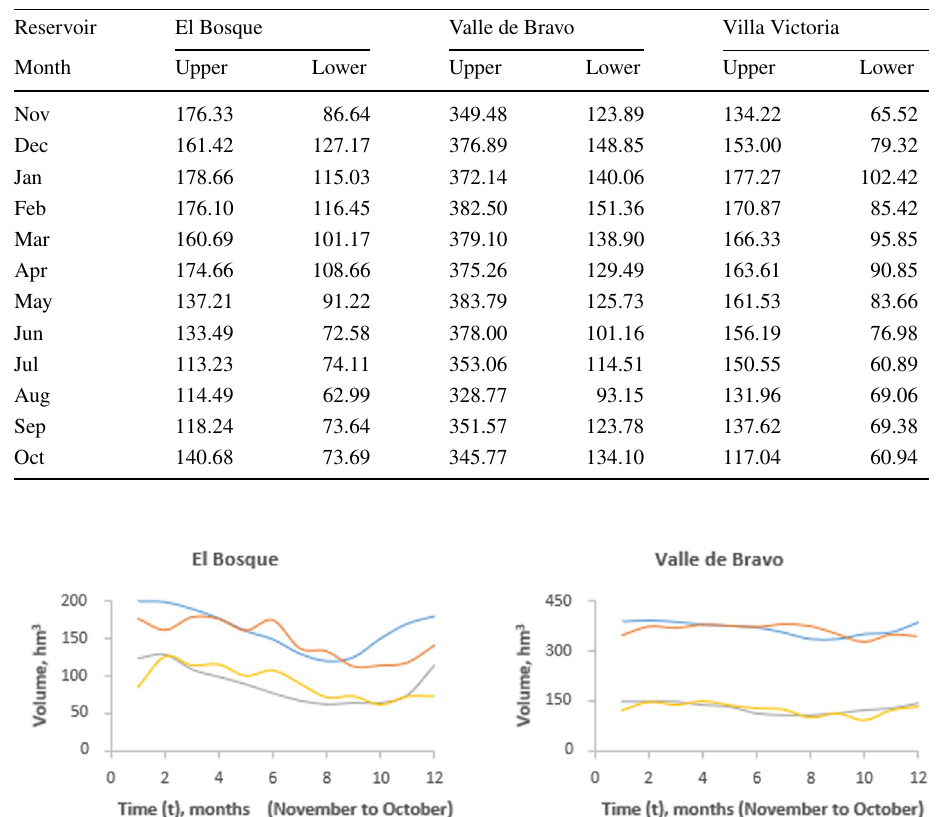
Table 5 Optimized upper and lower limit guide curve values for the Cutzamala System found with genetic algorithm GA2